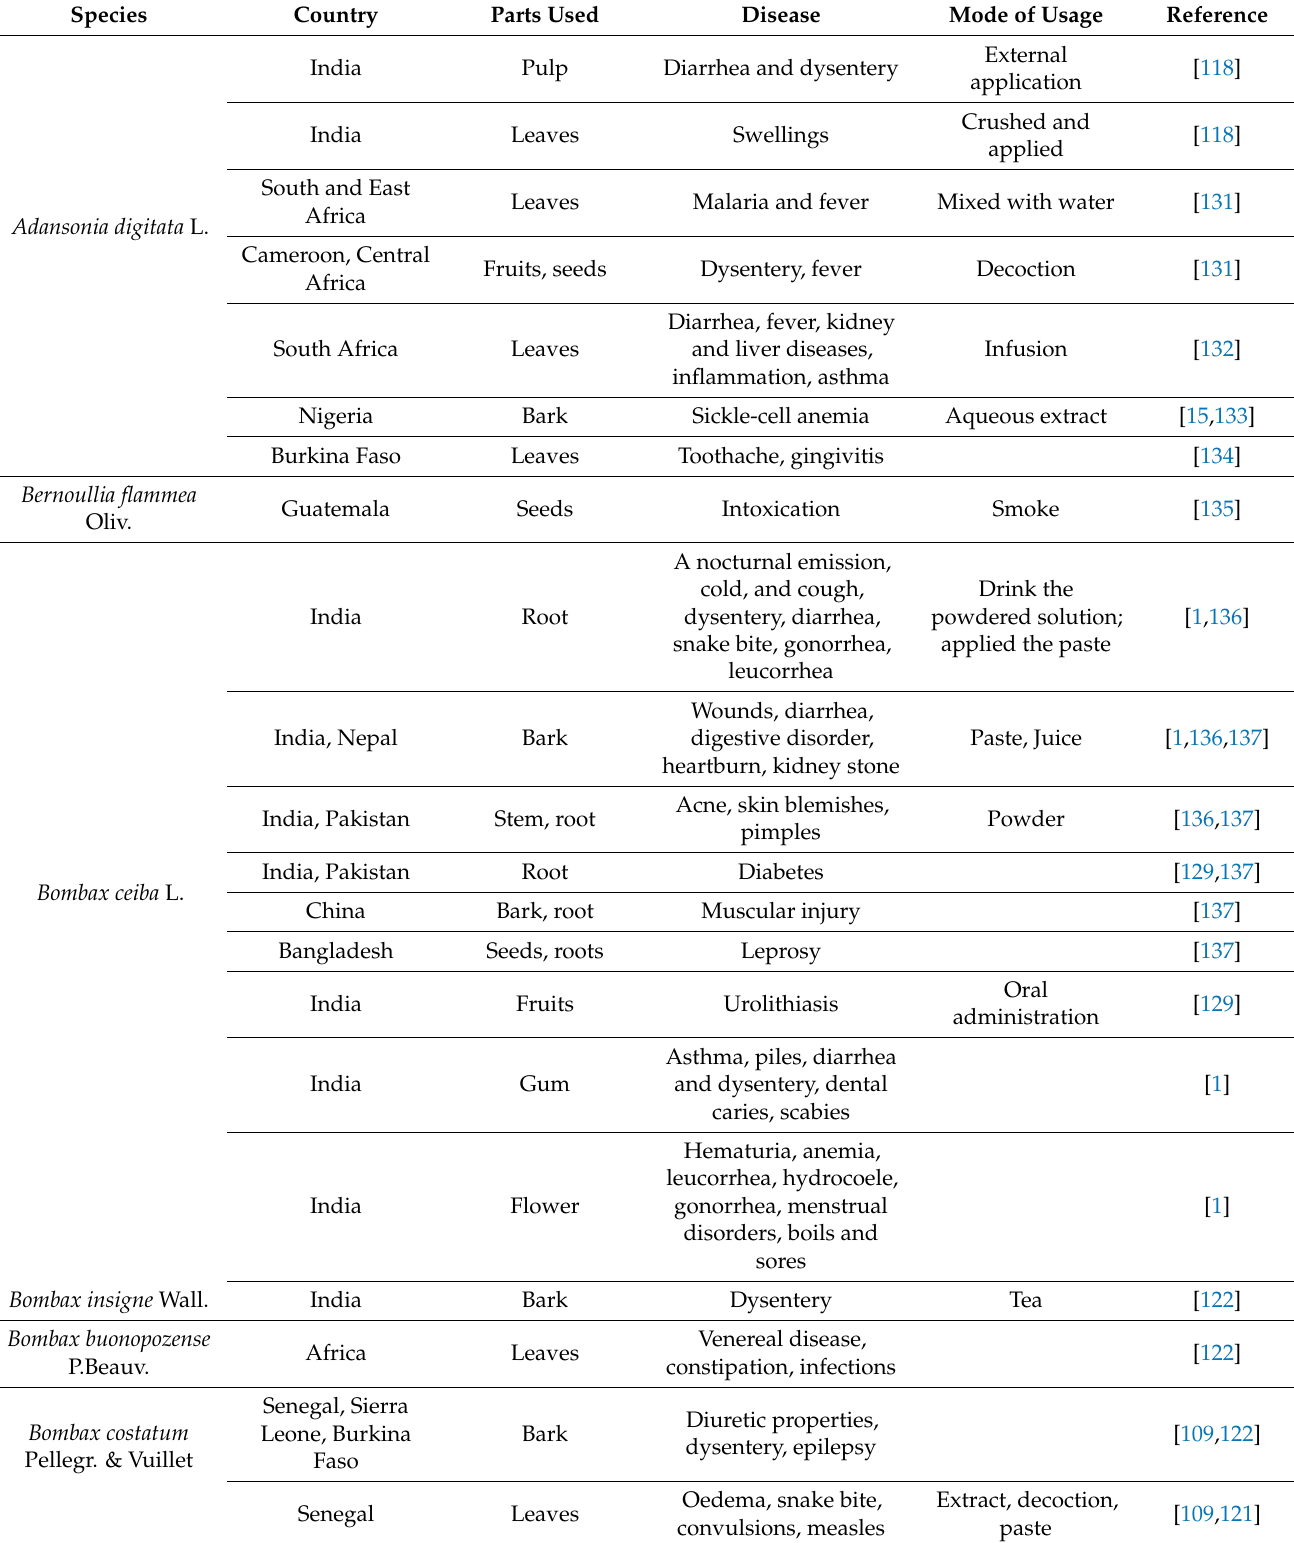
Table 5. Plants belonging to Bombacoideae with ethnopharmacological uses. Species Parts